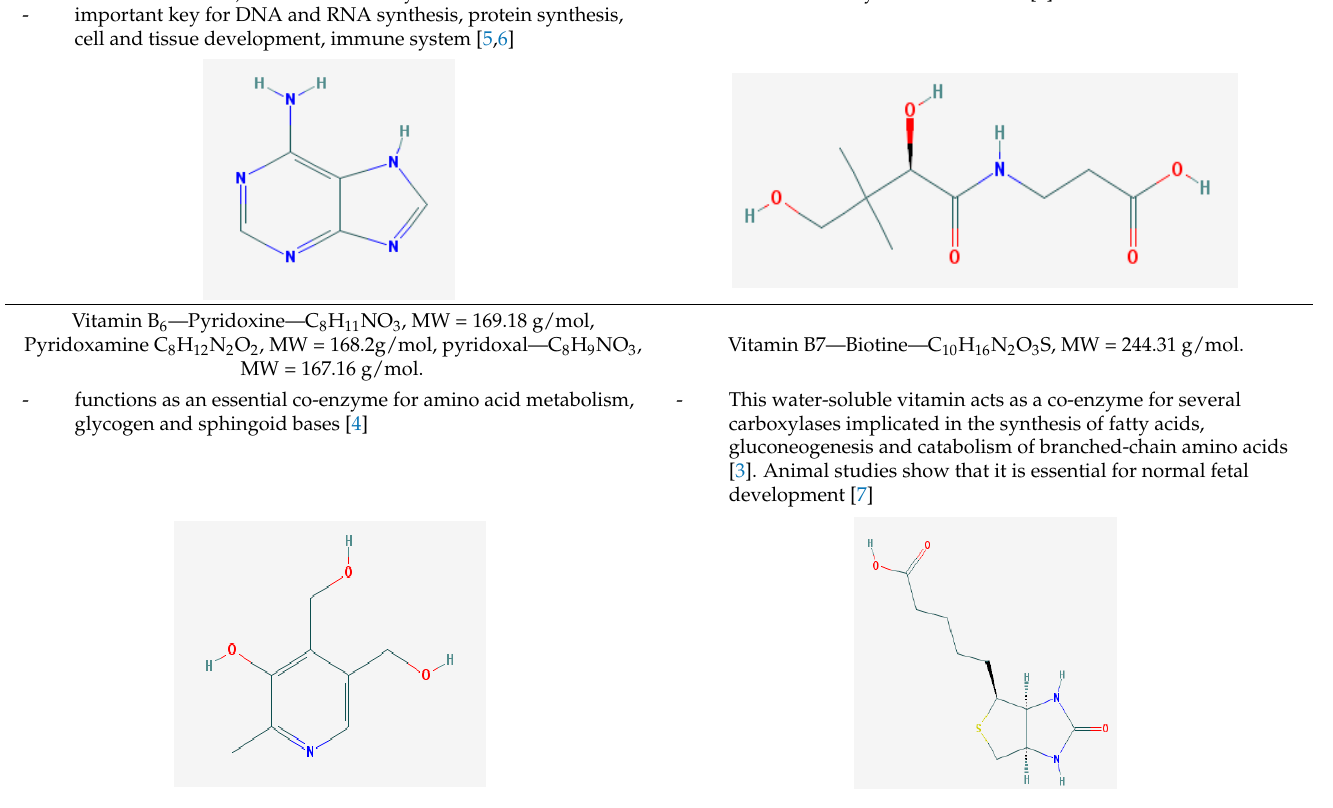
functions as a co-enzyme for the enzymes implicated in one-carbon metabolism; important for the DNA and RNA synthesis.